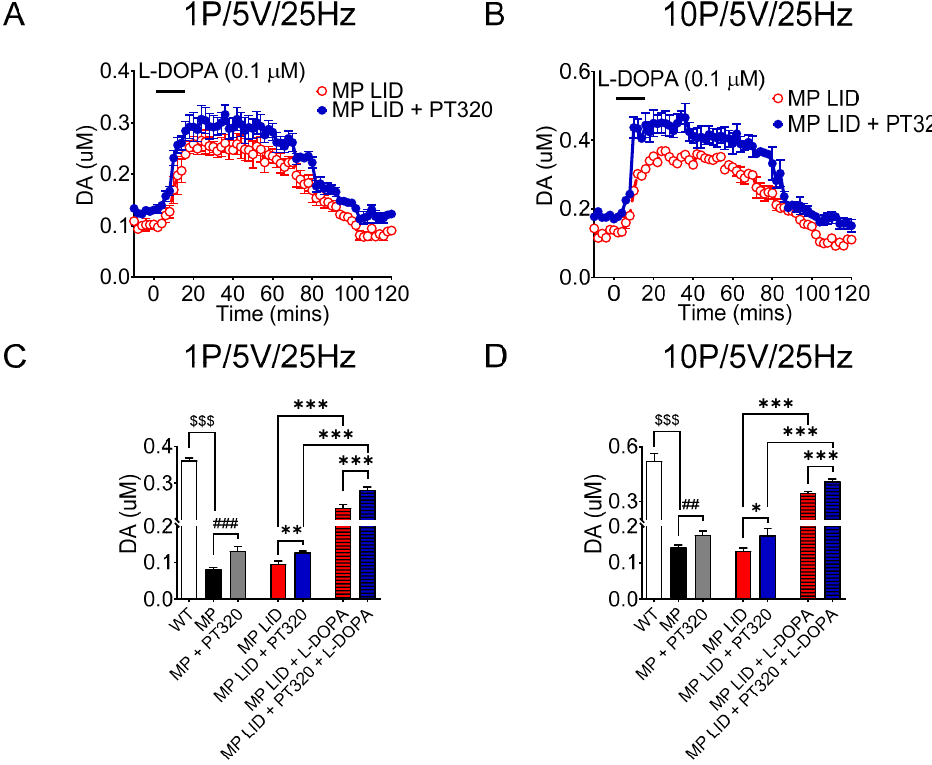
Figure 5. Evoked dopamine release measured via FSCV was augmented in the early PT320 treatment group. ( A ) The tonic release measured via FSCV in the PT320 treatment group in striatal slices after levodopa infusion showed that the PT320 treatment group (blue circle; MP LID + PT320 group) released higher DA concentrations than the non-treatment group (red open circle; MP LID